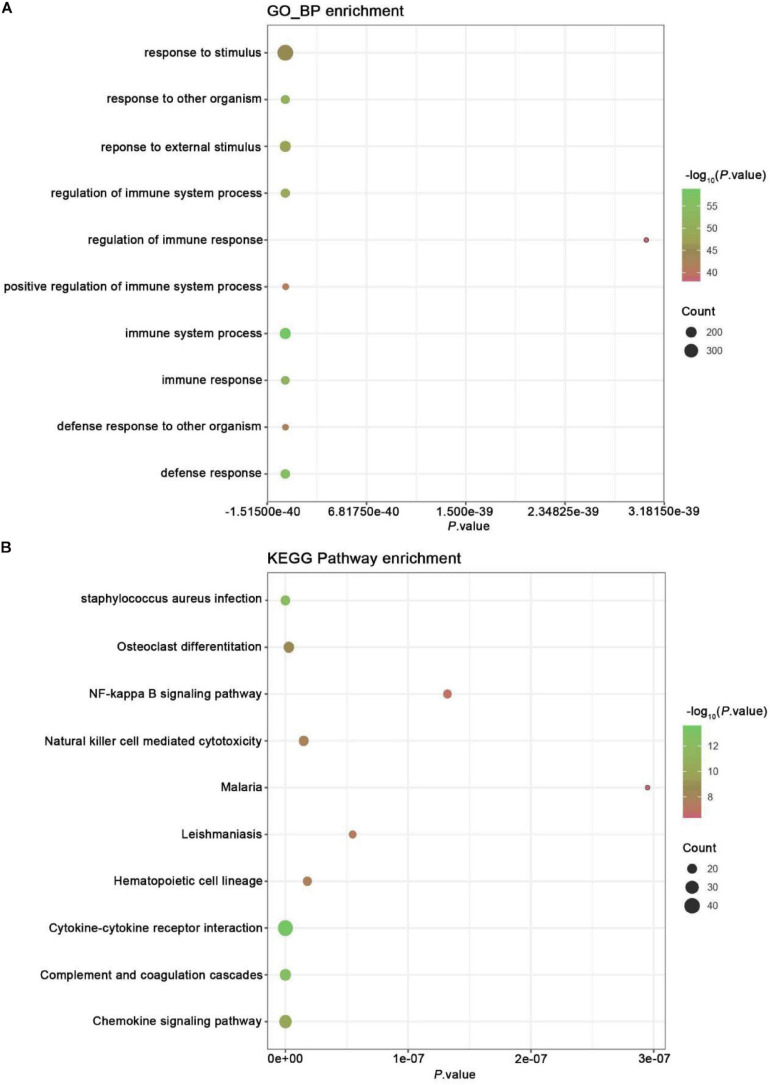
GO and KEGG pathway enrichment analysis. (A) GO analysis of all DEGs. The chart lists the richest Go terms of BP. (B) KEGG pathway analysis of all DEGs. The figure shows the most abundant KEGG pathway.